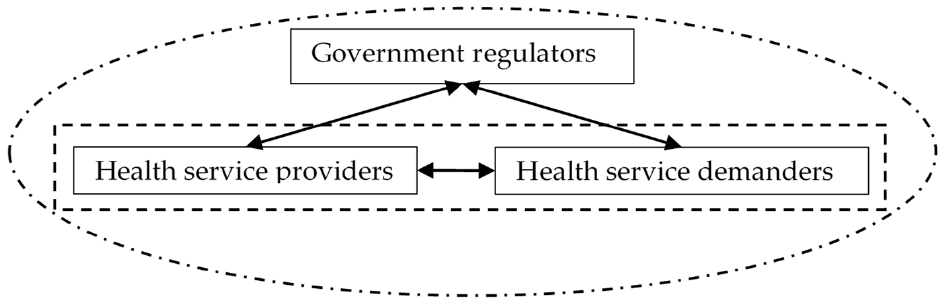
Figure 3. The stakeholders of integrated care.